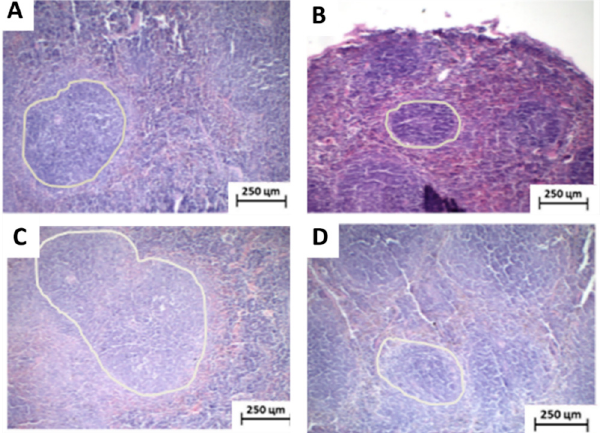
Figure 7. Photomicrographs of HE-stained histological sections of surgical specimens of spleen from rodents with sarcoma 180. ( A ) Vehicle group and ( B ) MRFE group 200 mg/kg/day, demonstrating extensive white hair region. ( C ) Group 5-FU alone and ( D ) Group 5-FU associated with MRFE 200 mg/kg/day, showing atrophy of the white fur. (×100).